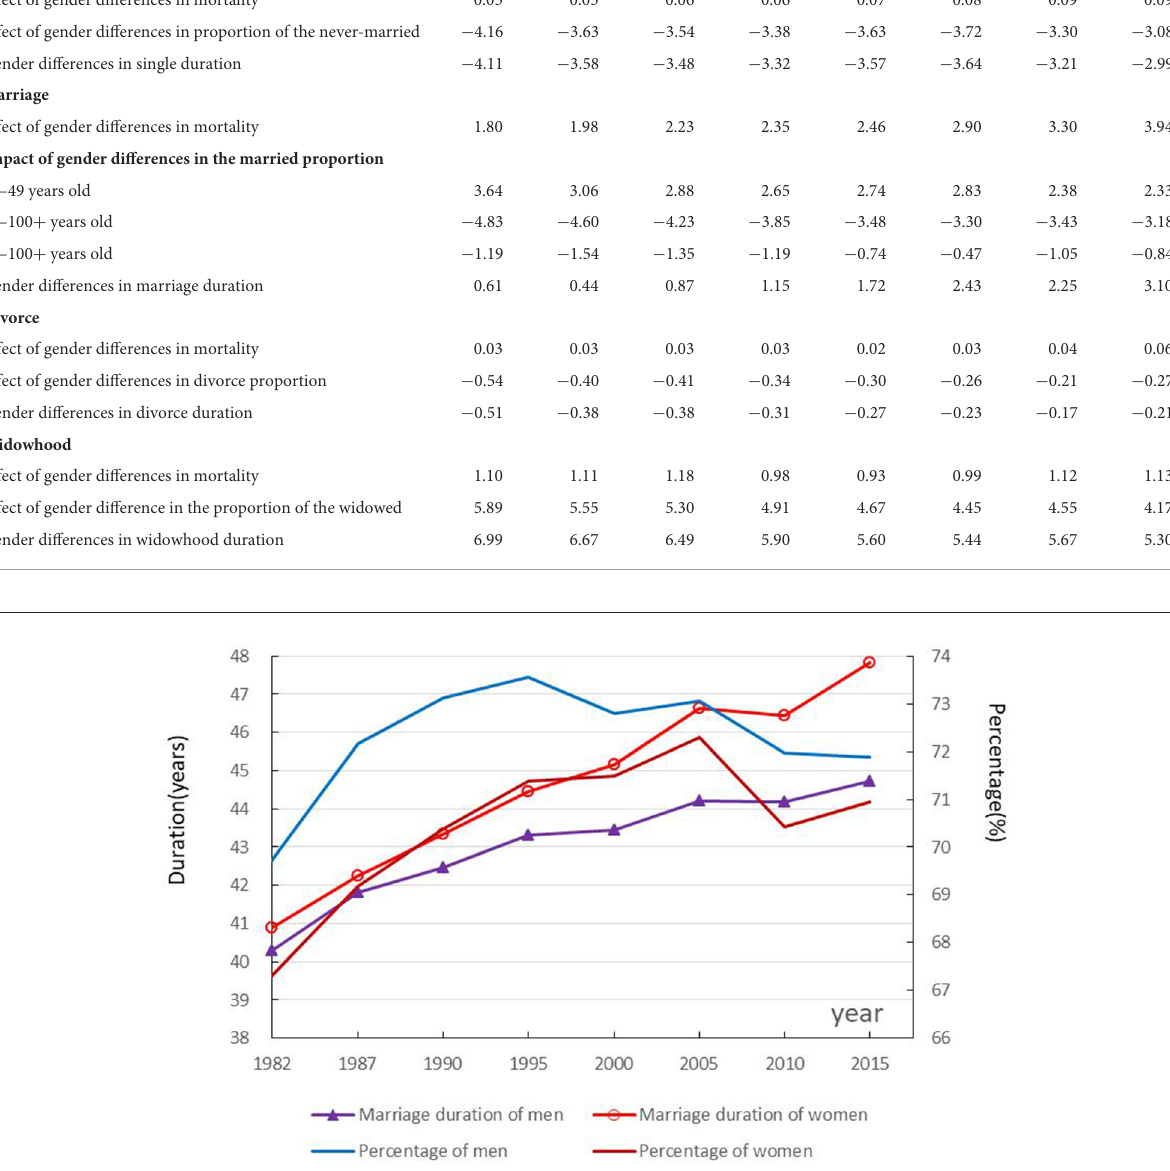
The marriage duration extended for both men and women in China in the 1982–2015 period, with women longer than men. However, the proportion of marriage duration in life